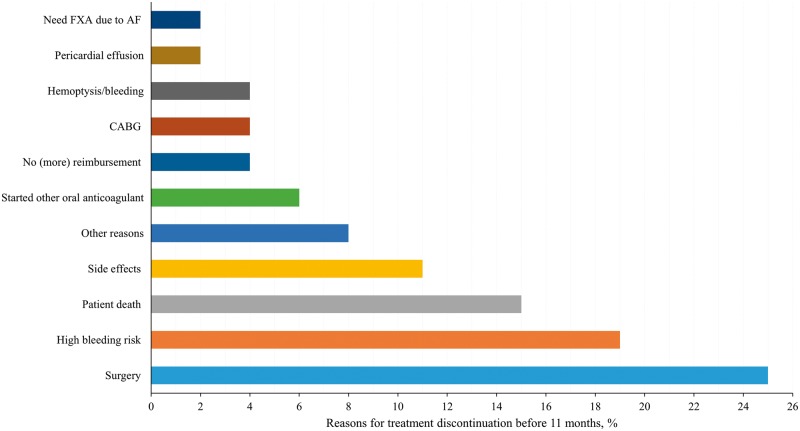
Reasons for stopping OAP treatment before 11 months. OAP, oral antiplatelet; CAGB, coronary artery bypass graft; FXA, coagulation factor X; AF, atrial fibrillation. Note: Other reasons were: standard practice; palliative care; no objective reasons/reasons related to patient.